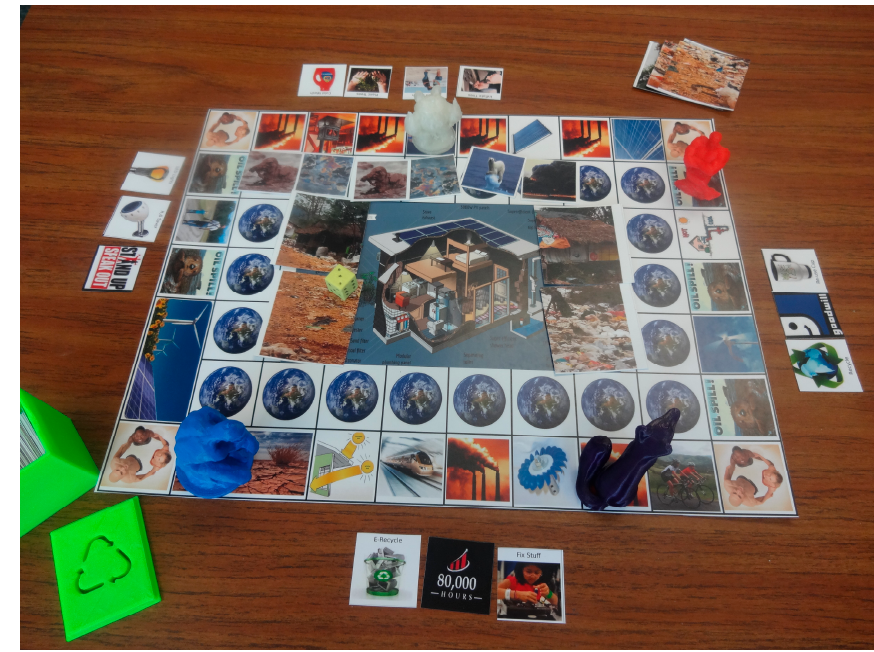
Figure 7. Open-source fully 2D and 3D printable do-it-yourself (DIY) cooperative Save the Planet Board Game in mid-play.